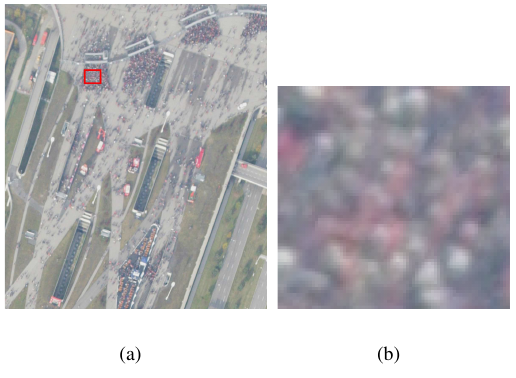
Figure 1: (a) Stadium 1 test image from our airborne image se- quence including both crowded and sparse people groups, (b) Closer view of a crowded region in Image 1